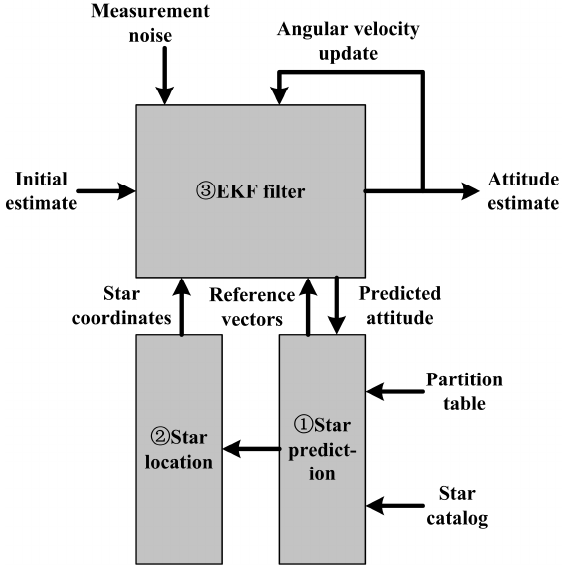
Figure 1. Tracking model of a star sensor.